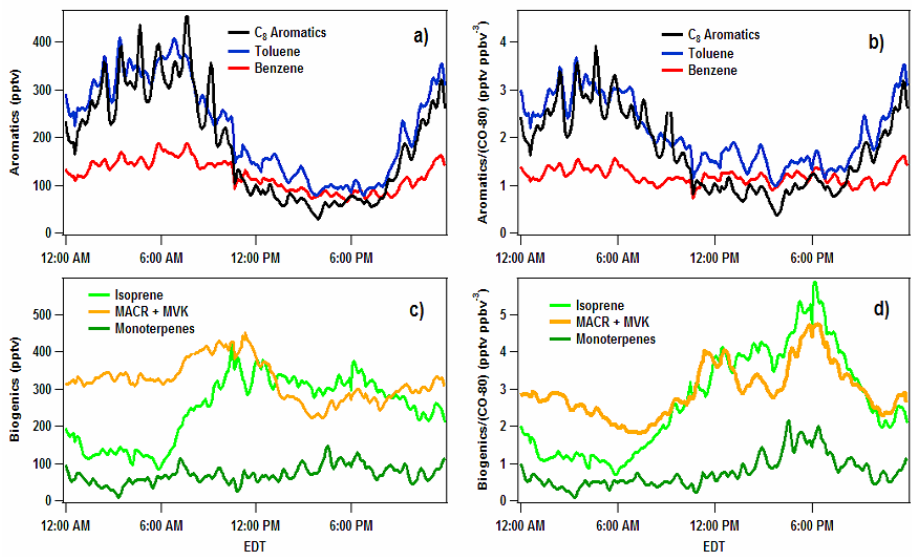
Figure 7. Diurnal profiles of aromatics (upper frames, a and b) and biogenic species (lower frames, c and d), without normalization to CO less its regional background value Fig. 7. Diurnal profiles of aromatics (upper frames, a and b ) and biogenic species (lower frames, c and d ), without normalization to CO less its regional background value (left frames, a and c ) and with normalization (right frames, b and d ). (left frames, a and c) and with normalization (right frames, b and d)